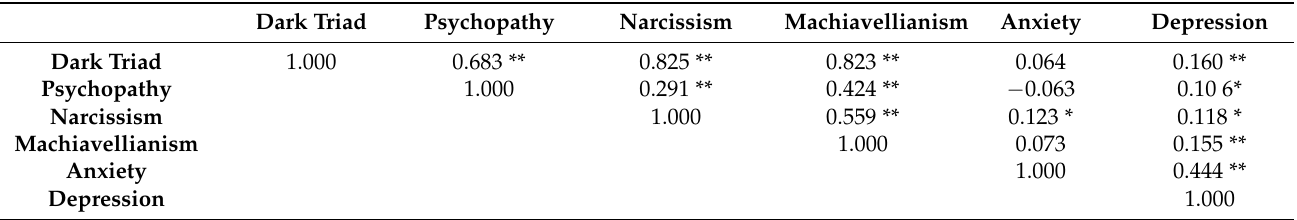
Table 6. Associations between the Dark Triad of personality, its components, symptoms of anxiety and depression in the entire study group.